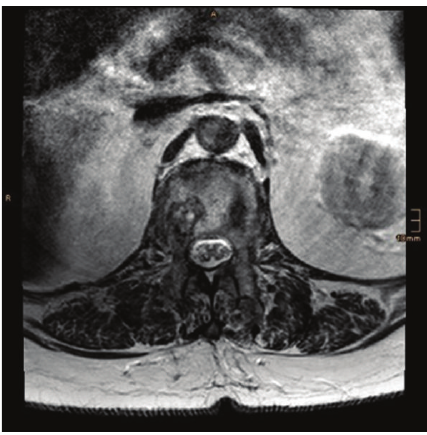
Figure 3: Postoperative axial MRI (T2-weighted) at the level of